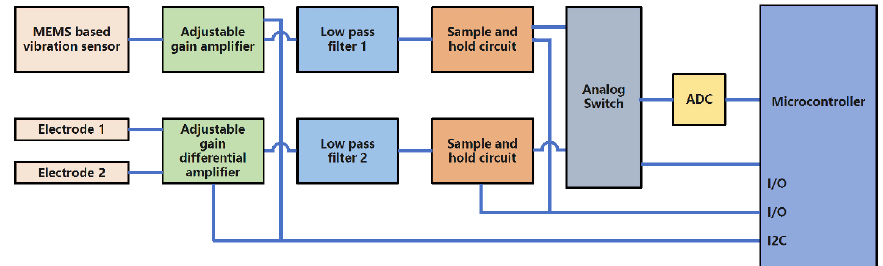
Figure 4. The block diagram of synchronized ECG and PCG. The MEMS-based vibration sensor is used to detect PCG signals. The adjustable gain amplifier is used to adjust the gain and it is controlled by microcontroller firmware. The PCG signal passes a low pass filter to eliminate high-frequency noises. On the ECG side, two electrodes are used to collect ECG signals. The ECG signals pass through the adjustable gain differential amplifier. The gain is controlled by microcontroller firmware. The ECG signal passes through a low pass filter to eliminate high-frequency noise. To achieve the simultaneous collection of both ECG and PCG, two samples and hold circuits are employed. The two sample and hold circuits are controlled by one digital output from the microcontroller. The microcontroller uses one digital output to sample and hold both ECG and PCG analog signals. After sampling and holding the ECG and PCG, an analog switch is employed to select ECG or PCG to pass ADC to digitize the analog signal.